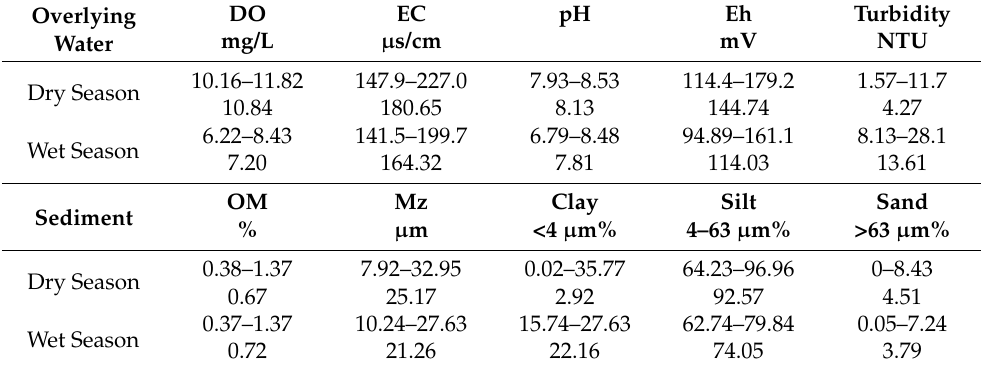
Table 1. The properties of sediments and overlying water. DO: dissolved oxygen; EC: electrical conductivity; Eh: redox potential; OM: organic matter; Mz: mean grain size.